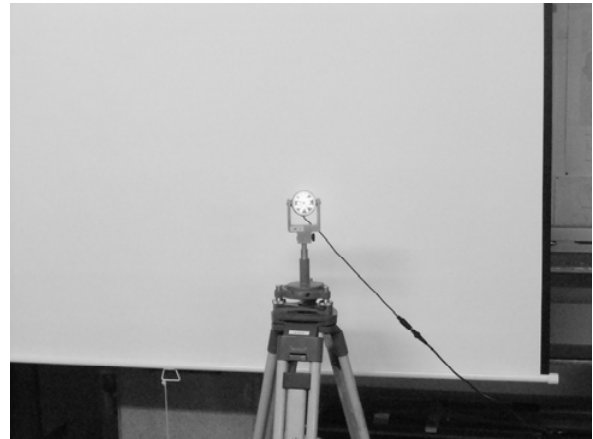
Figure 4. Experimental setup: Target position (picture taken by Elsa Heer)